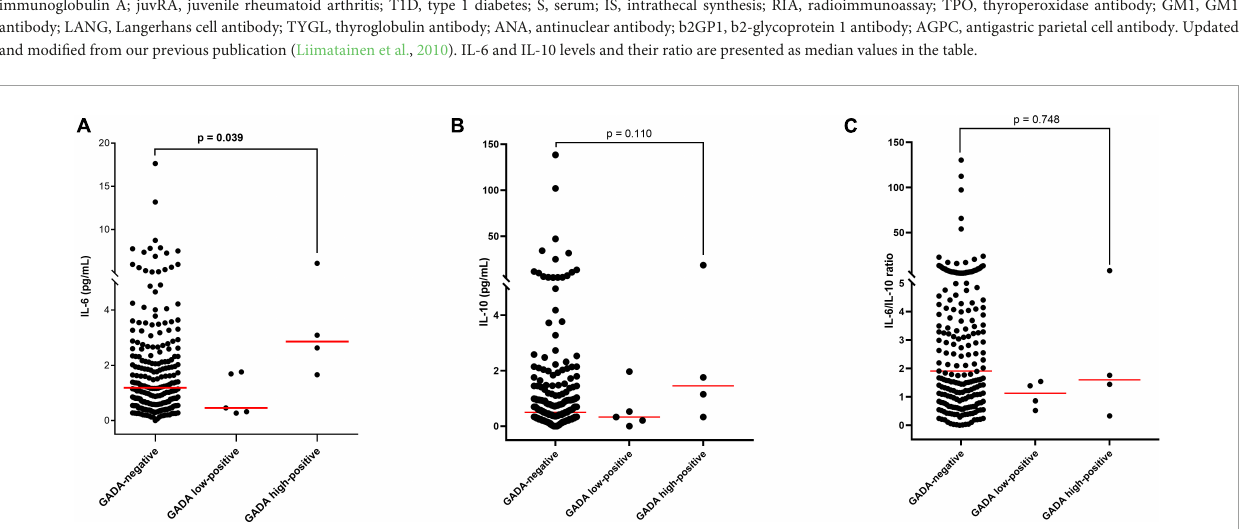
support the idea that IL-6-mediated systemic inflammation could also be the cause for the presence of high titers of